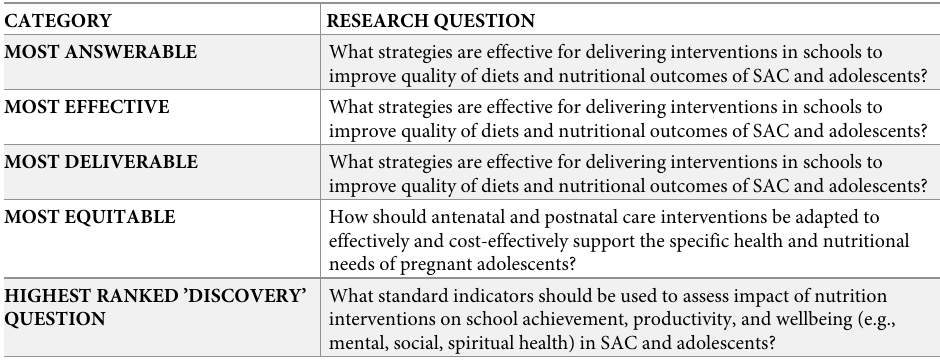
Table 6. Top ranked questions according to priority-setting